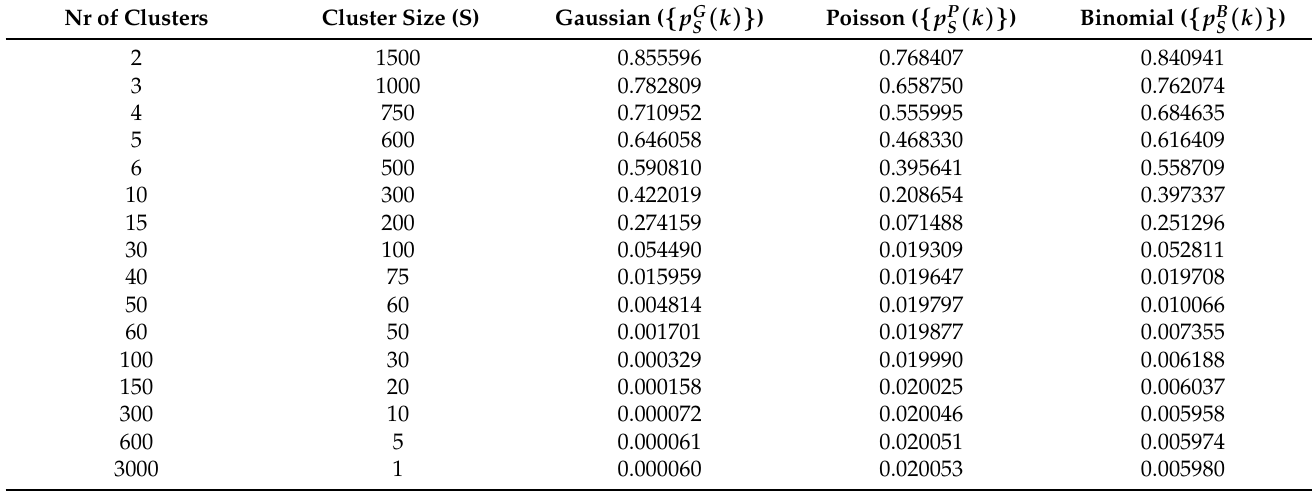
Table 4. Total variational distance between the approximated and the exact degree distribution when the IRG is created using Range ( 3000 ) parametrization and the clusters are given by C S ( V )